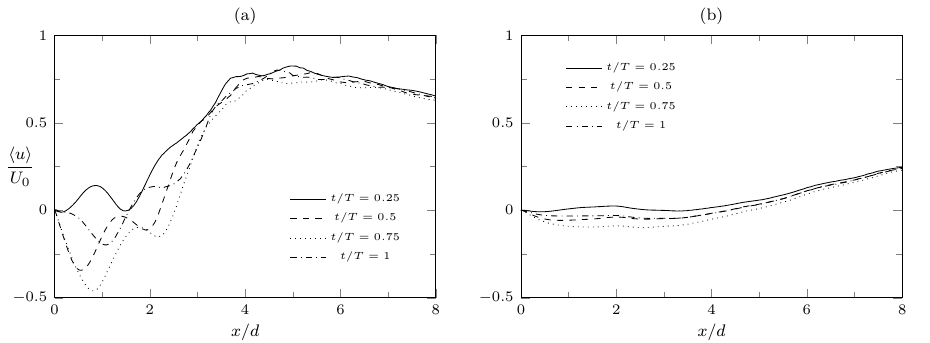
Figure 13. Distribution along the x axis of the streamwise component of the phase-averaged flow u field , for different phases: t / T = 0.25, 0.5, 0.75, 1. ( a ) s o / d = 2.5, ( b ) s o / d = (cid:104) (cid:105)